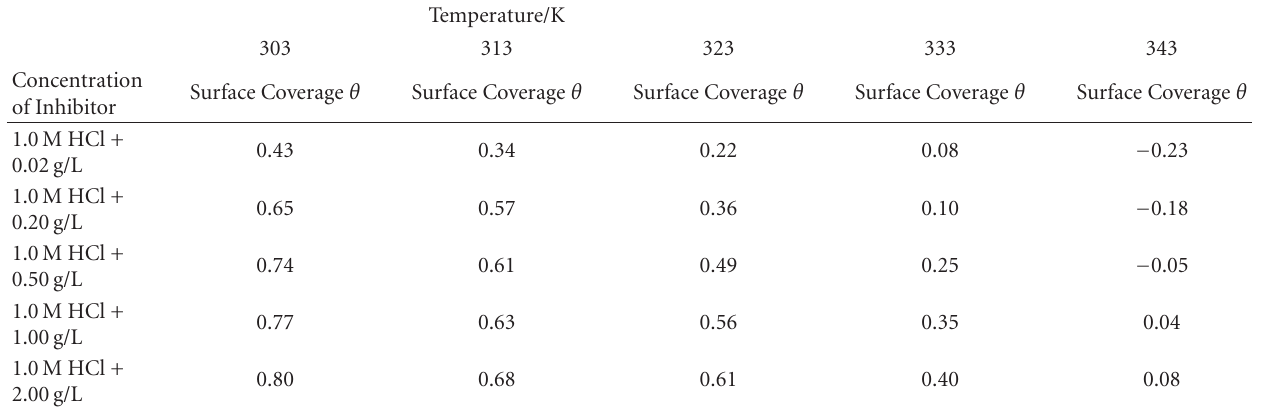
Table 6: The E ff ect of concentration of the aqueous extract of Neem leaves on surface coverage for carbon steel in 1.0 M HCl at various temperatures.